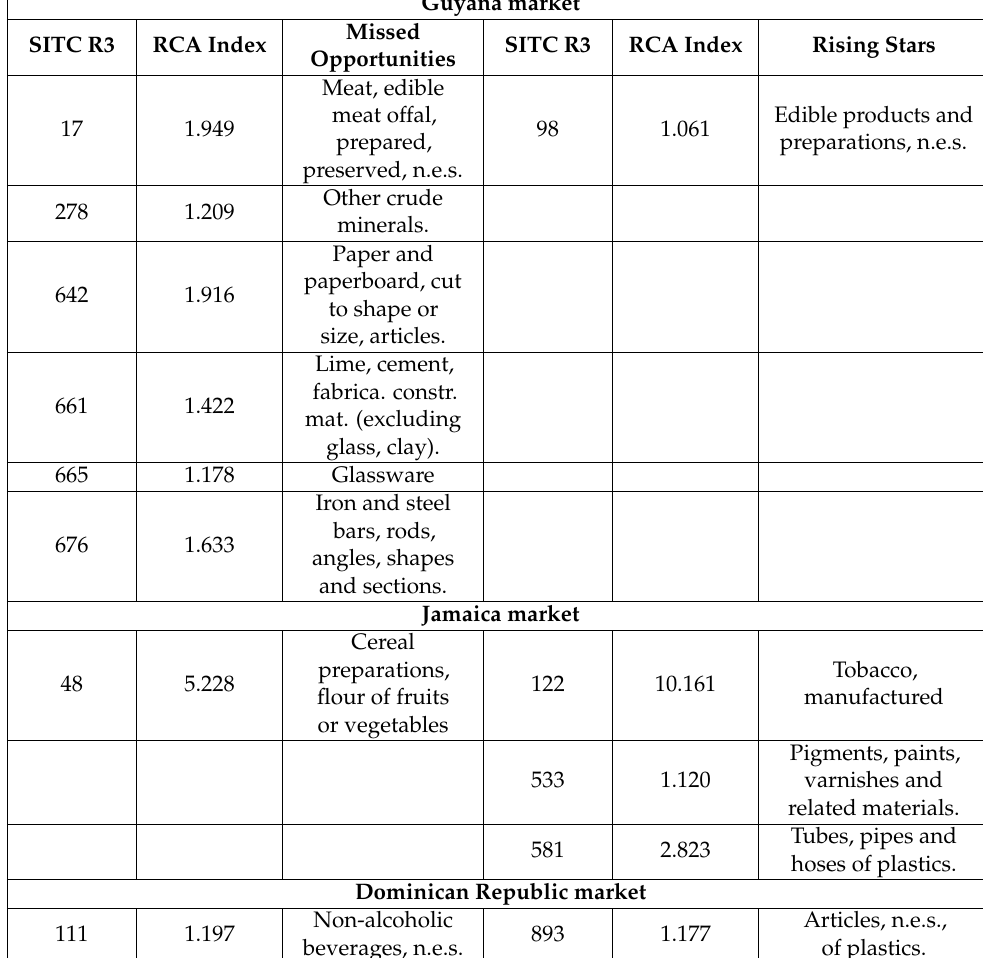
Table A7. Examples of feasible export areas for T&T’s main intra-regional